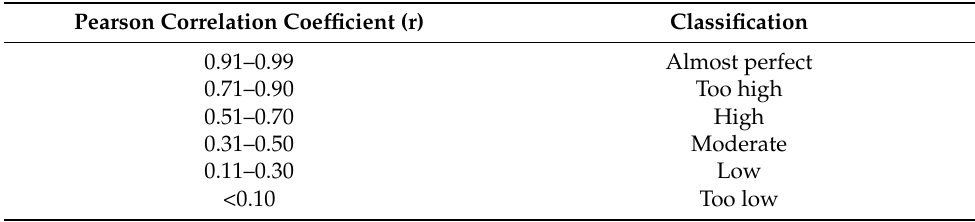
Table 3. Pearson correlation coefficient performance classification (r) [47].